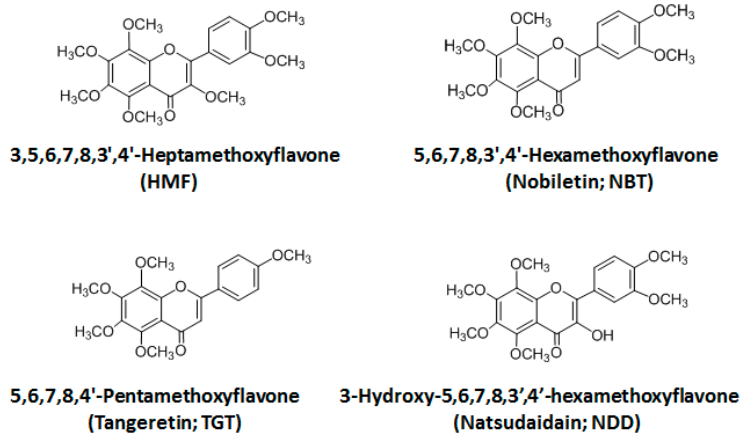
Chemical structures of 3,5,6,7,8,3 ′ ,4 ′ -heptamethoxy-flavone (HMF), nobiletin (NBT), tangeretin (TGT), and natsudaidain (NDD).